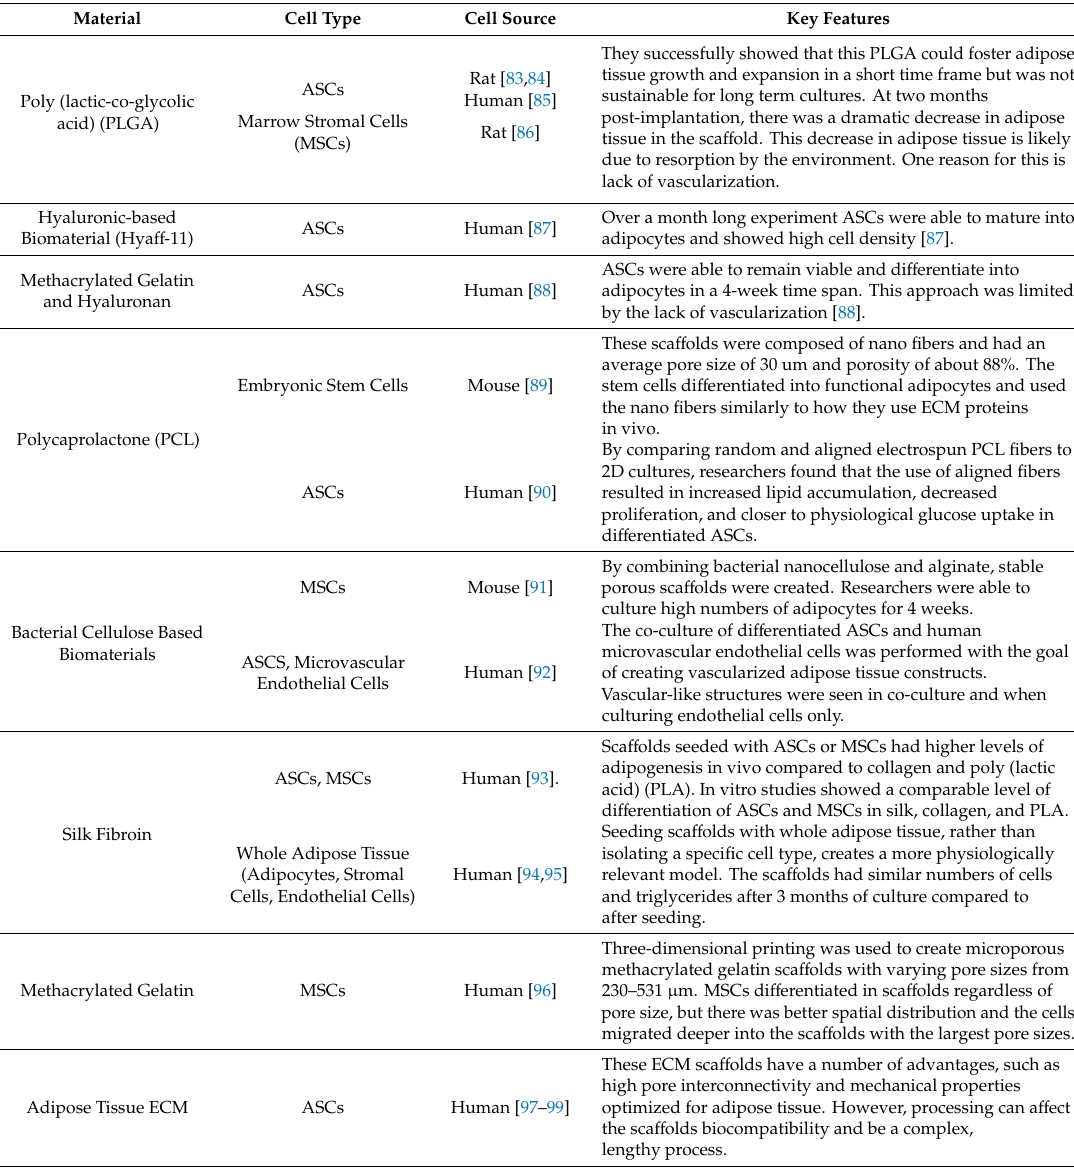
Table 1. Biomaterials that have been used in vitro to culture adipose